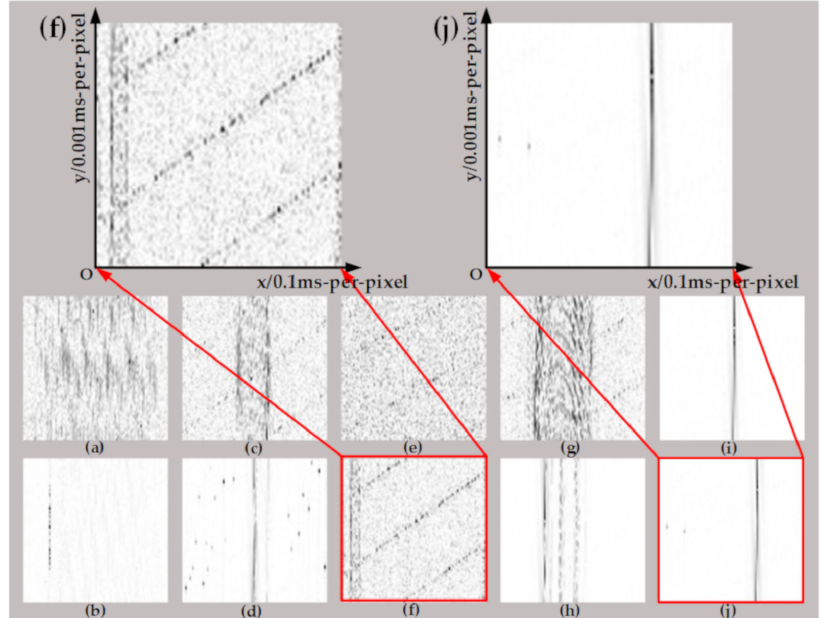
Figure 6. Arc and normal gray image after filtering. ( a ) Vacuum cleaner_Normal; ( b ) Computer_Normal; ( c ) Heater_Normal; ( d ) Fluorescent lamp_Normal; ( e ) Dimmer_Normal; ( f ) Vacuum cleaner_Arc; ( g ) Computer_Arc; ( h ) Heater_Arc; ( i ) Fluorescent lamp_Arc; ( j )